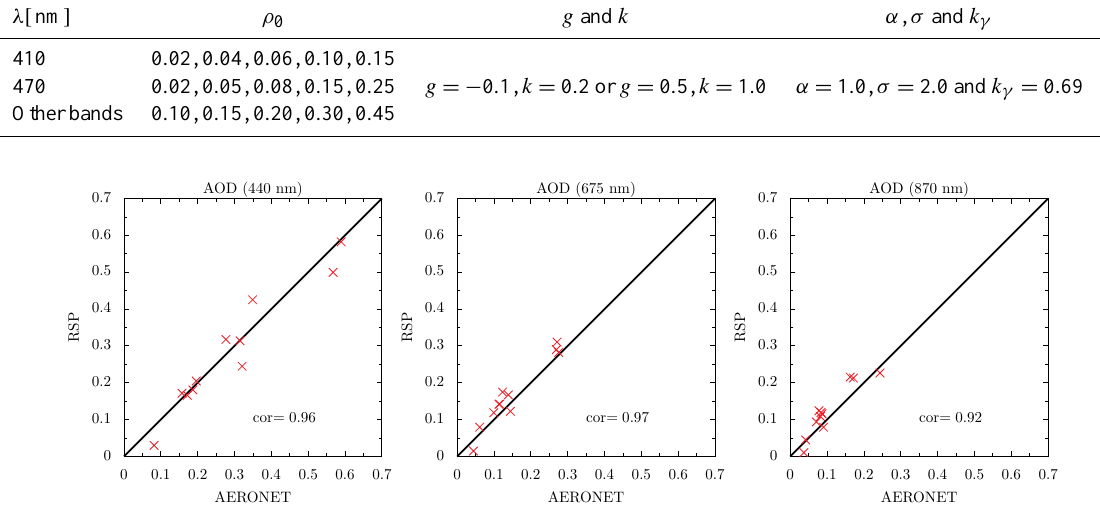
Figure 7. Comparison between the retrieved AOD of RSP measurements and AERONET at 440, 675 and 870nm. The correlation coefficients (cor) at each wavelength are included.